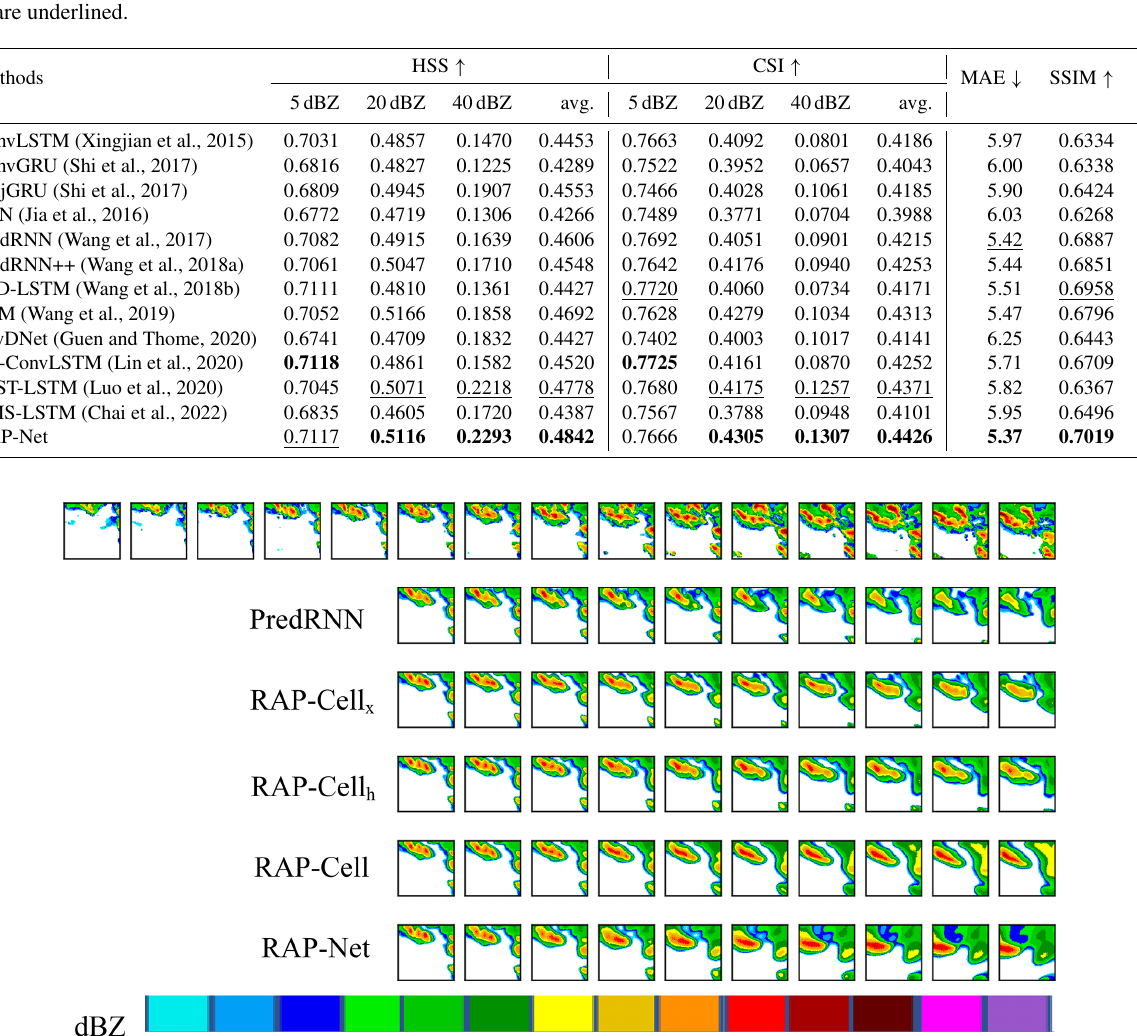
Figure 9. The first row is the reflectivity of the ground truth and the remaining rows are the predicted reflectivity of different methods on an example from the RadarCIKM dataset (best viewed in